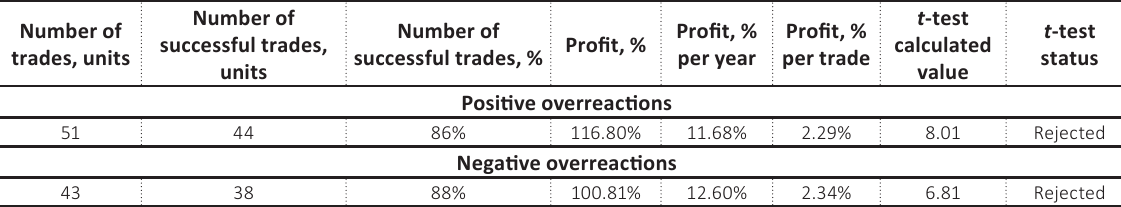
Table 4. Trading simulation results for the day of overreaction: case of the Momentum Strategy Number of trades, units